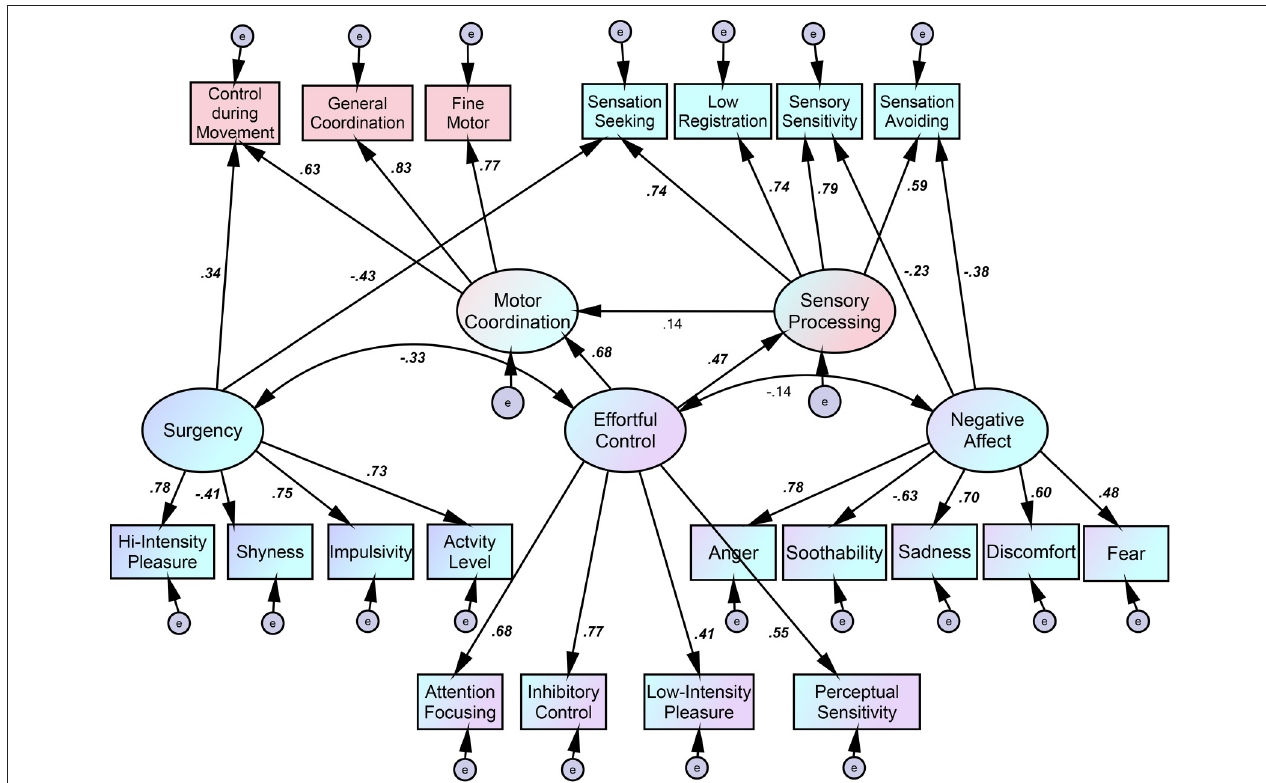
FIGURE 1 | Path diagram of causal relations between temperament, sensory processing, and motor coordination in 3-year-olds (based on the original three-factor temperament model). Coefficients are standardized beta values. Italic, Bold, p <